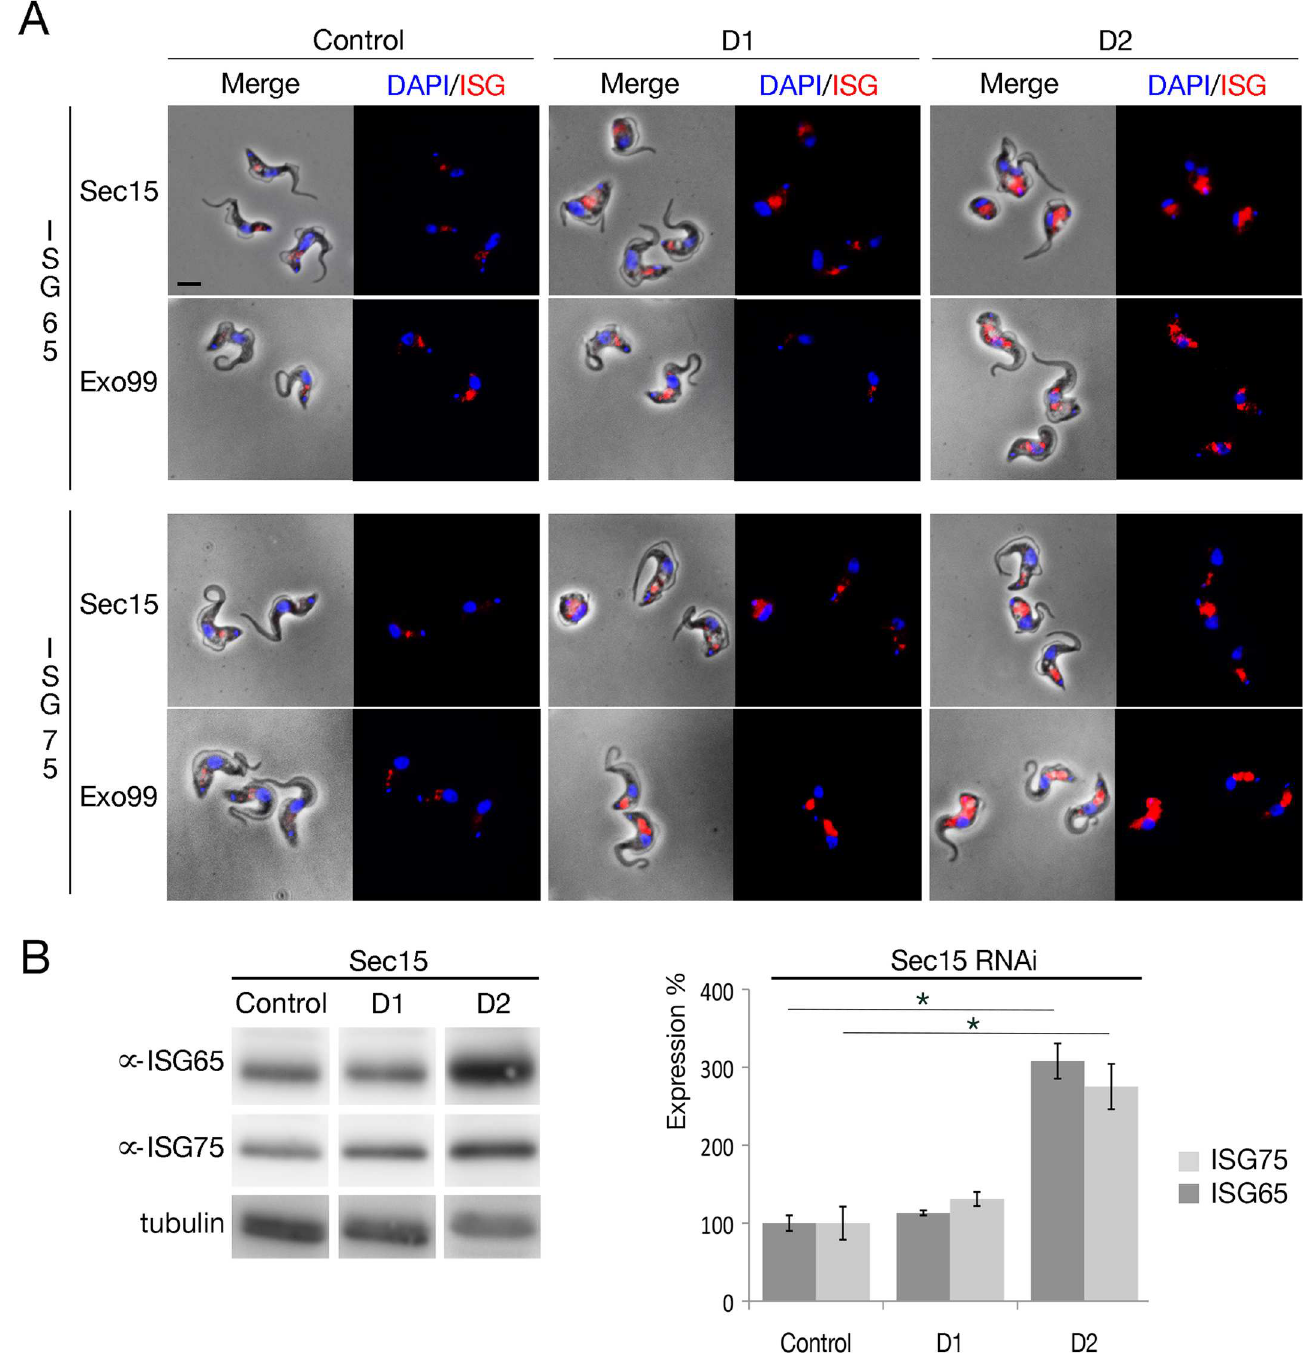
Fig 6. Exocyst mediates control of invariant surfaceglycoprotein expression levels. (A) The localisation and relativeexpressionlevel of the intracellularISG65 and ISG75 pool were assessedby immunofluorescence microscopy with specific antibodies (red), in control cells and in Sec15 and Exo99 RNAi cells at 24 and 48h post induction.In both RNAi lines the intracellular ISG pool is significantincreased.Scale bar, 5 μ m (B) Expression of total ISG65 and ISG75 in Sec15 RNAi cells at 24 (D1) and 48h (D2) post inductiondetected by Western blot. Steady-state ISG expressionis significantly increasedin Sec15 RNAi cells comparedto control. N = 3 independentexperiments normalized to tubulinsignal.